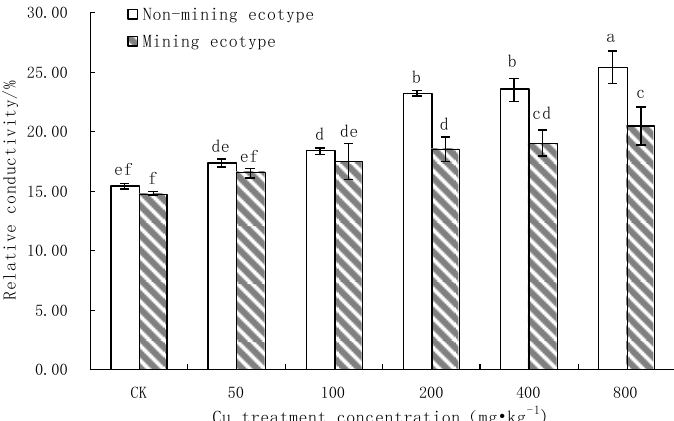
Figure 3. Change in relative conductivity of two ecotypes of M. floridulus under different Cu treatment. Note: Error bars indicate standard deviation; Different letters in the same group indicate significant difference at p < 0.05 according to Duncan’s multiple range tests; the same below.